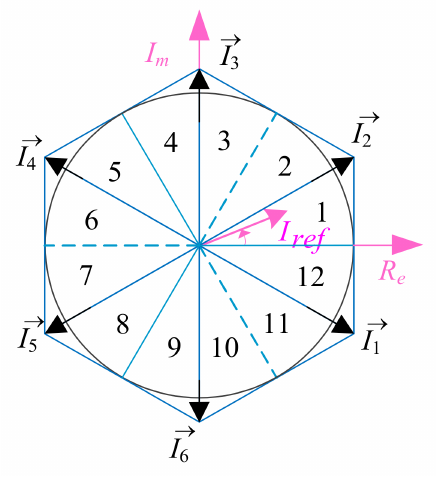
Figure 6. New current space vector diagram.